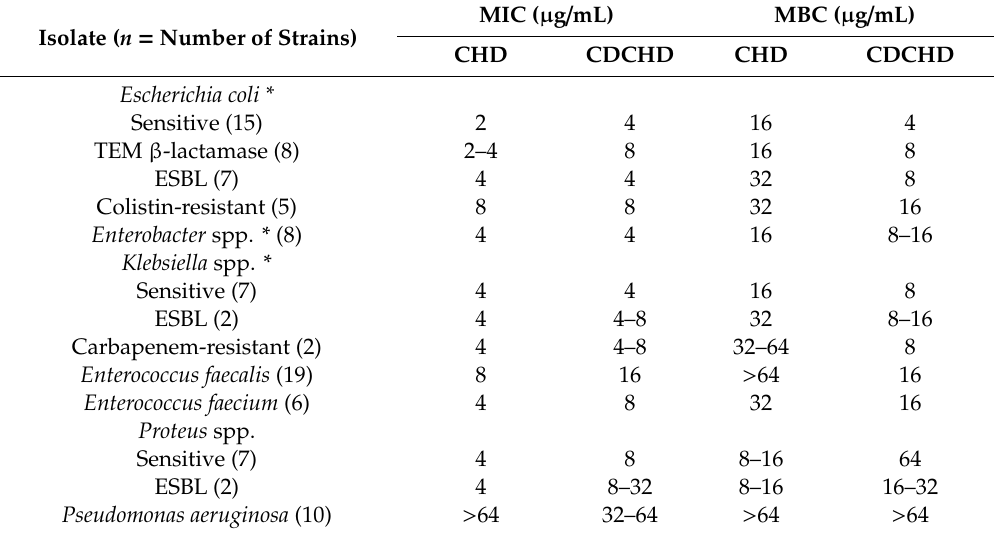
Table 1. Minimal inhibitory concentrations (MICs) and minimum bactericidal concentrations (MBCs) of CHD and CDCHD against uropathogenic clinical isolates grown in cation-adjusted Mueller–Hinton broth (CAMHB).